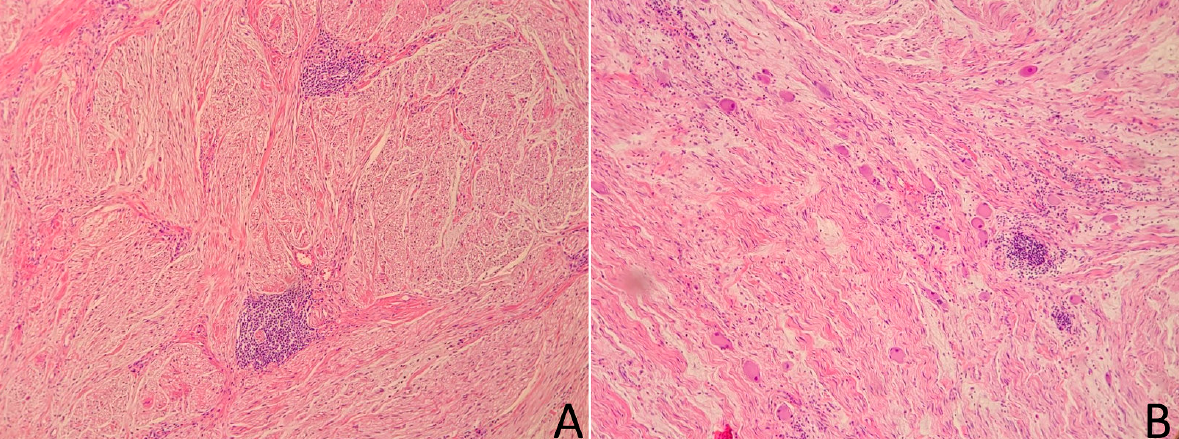
Figure 11. Ganglioneuroma—the tumor is mainly composed of Schwann cells forming fascicles in the myxoid stroma (( A ), hematoxylin and eosin, 400× magnification). The mature ganglion cells are scattered throughout the tumor in small groups; they are characterized by abundant, eosinophilic cytoplasm and a round, eccentrically located nuclei (( B ), hematoxylin and eosin, 400× magnification). Furthermore, focal lymphocytic infiltrates are visible (well visible in photo ( A )).